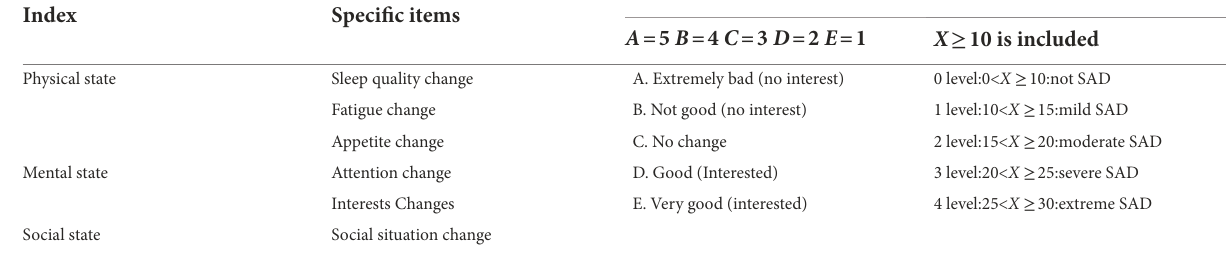
TABLE 1 Scoring criteria table of winter SAD tourists inclusion.